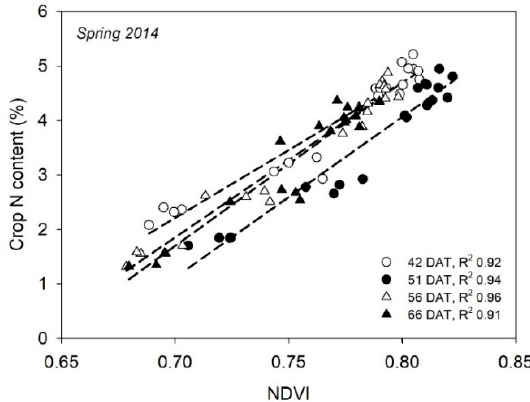
Figure 4. Linear relationships of the Normalized Difference Vegetation Index (NDVI), measured in the upper part of the crop canopy with a Crop Circle ACS 470 sensor, to standing crop N content from a greenhouse-grown cucumber crop in Spring 2014 carried out in southeast Spain. DAT is days after transplanting and R 2 is the coefficient of the determination of linear regression.